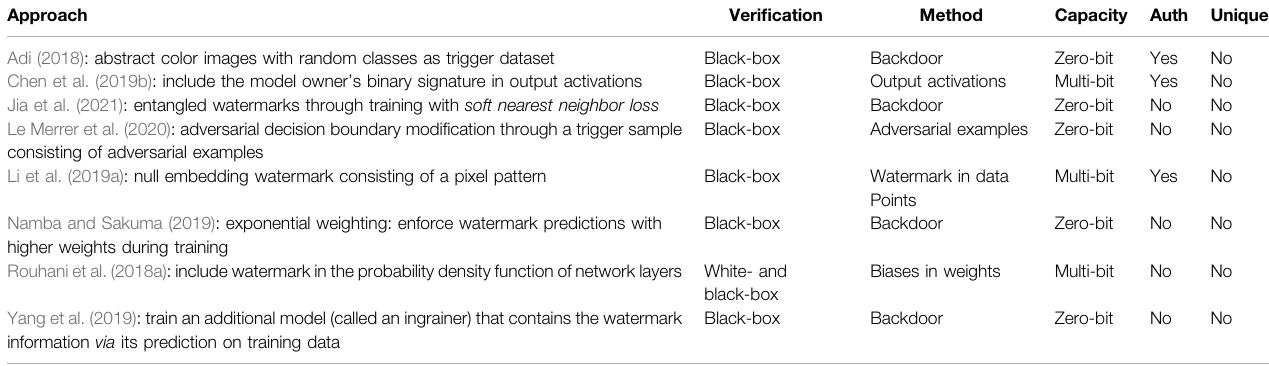
TABLE 3 | Techniques using a speci fi c trigger dataset as a watermark sorted alphabetically by author.